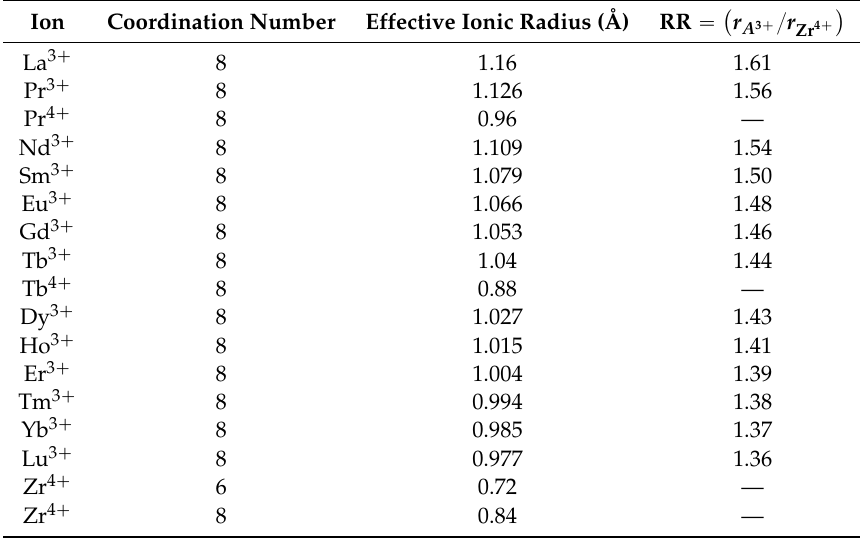
Table 1. Effective ionic radii [26] of lanthanides and zirconium ions and the calculated ionic